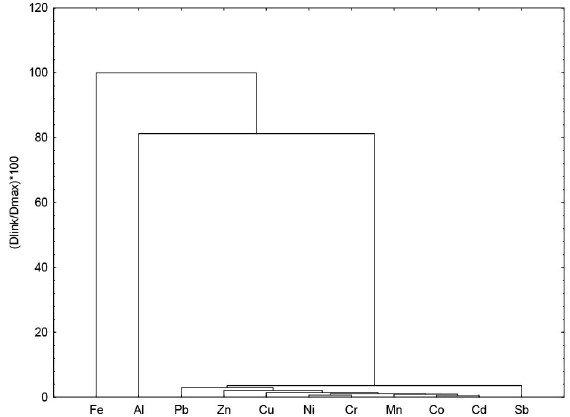
Figure 2. The dendrogram of the cluster analysis of elements based on their concentrations